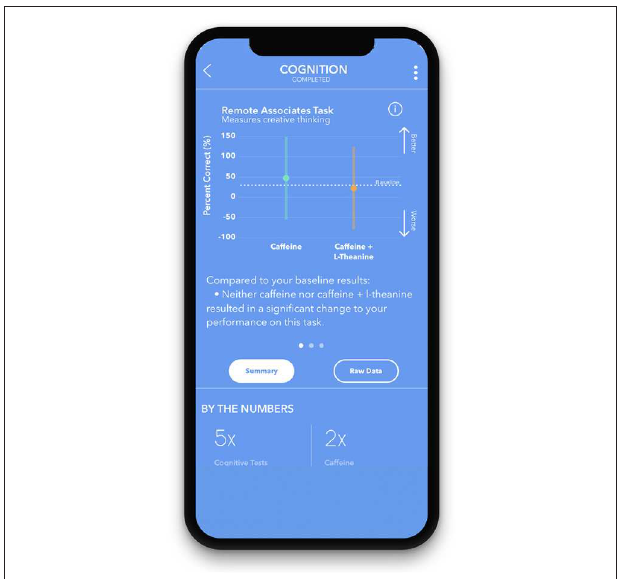
FIGURE 6 | Sample of summary results